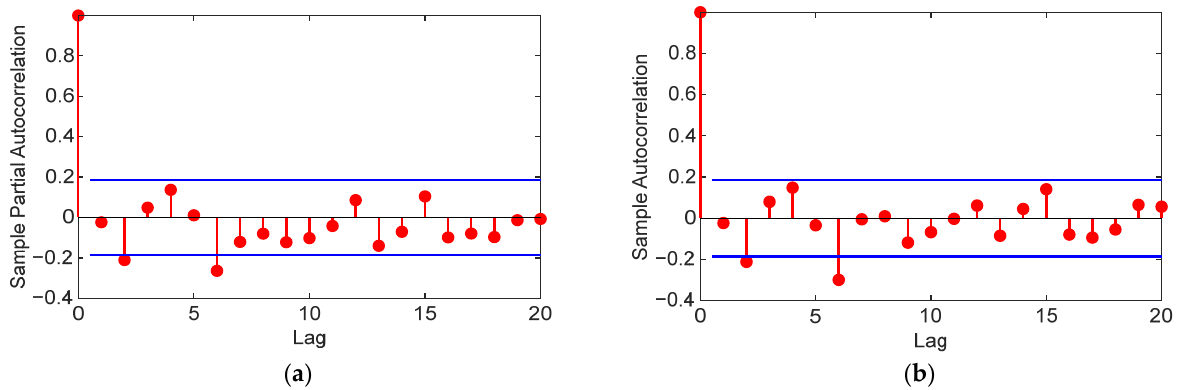
Figure 10. Analysis results after the second-order difference of the original velocity sample: ( a ) sample partial-autocorrelation function and ( b ) sample autocorrelation function.